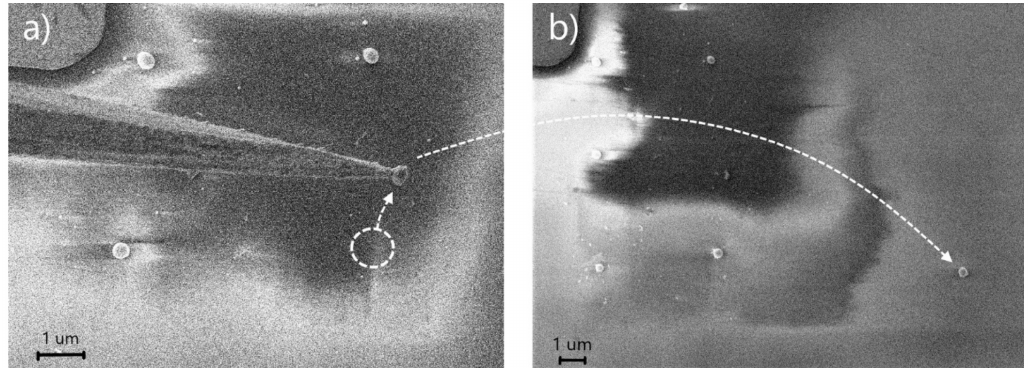
Figure 1. The process of manipulation of a single silicon nanoparticle on a glass substrate. ( a ) a tungsten tip with an attached silicon nanoparticle 250 nm in diameter from the glass; ( b ) the result of the transfer of the picked-up particle from the tungsten tip back to the surface of the